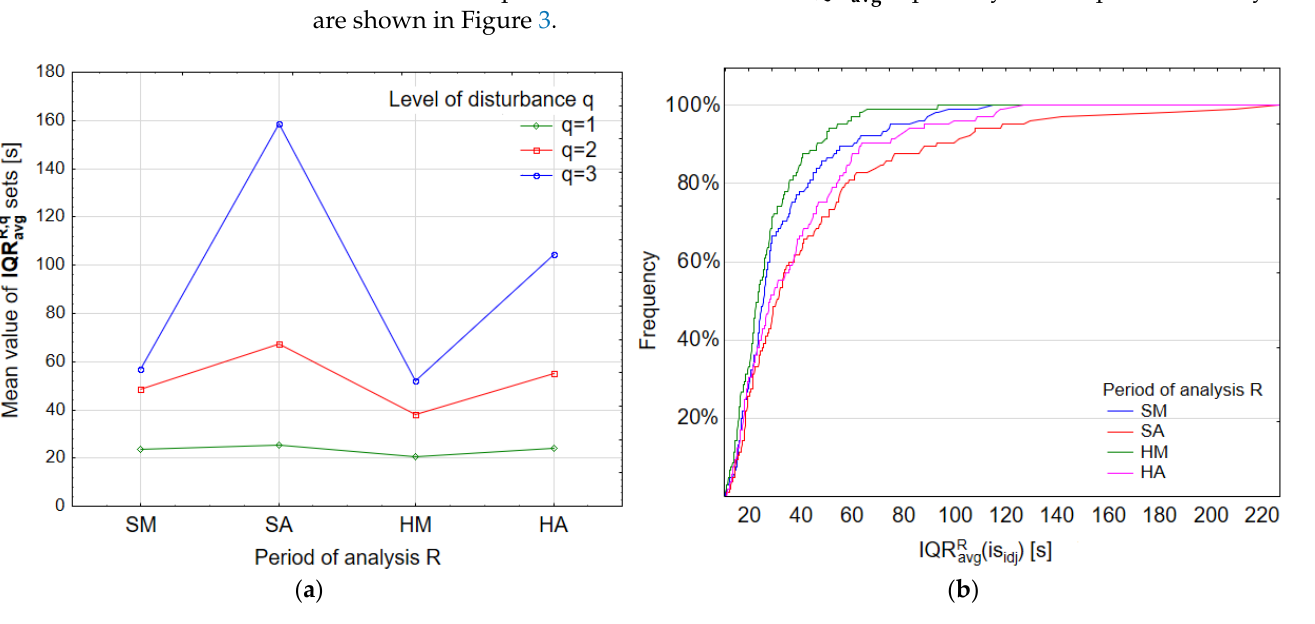
Figure 3. Results of the analysis of dispersion of 𝐼𝑄𝑅 (cid:2911)(cid:2932)(cid:2917)(cid:2902) (cid:3435)𝑖𝑠 (cid:3036)(cid:3031)(cid:3037) (cid:3439) values: ( a ) Means of sets 𝑰𝑸𝑹 𝐚𝐯𝐠𝐑,𝐪 separately in each period of analysis and each level of dispersion; ( b ) cumulative histograms of elements of sets 𝑰𝑸𝑹 𝐚𝐯𝐠𝐑 separately in each period of analysis.